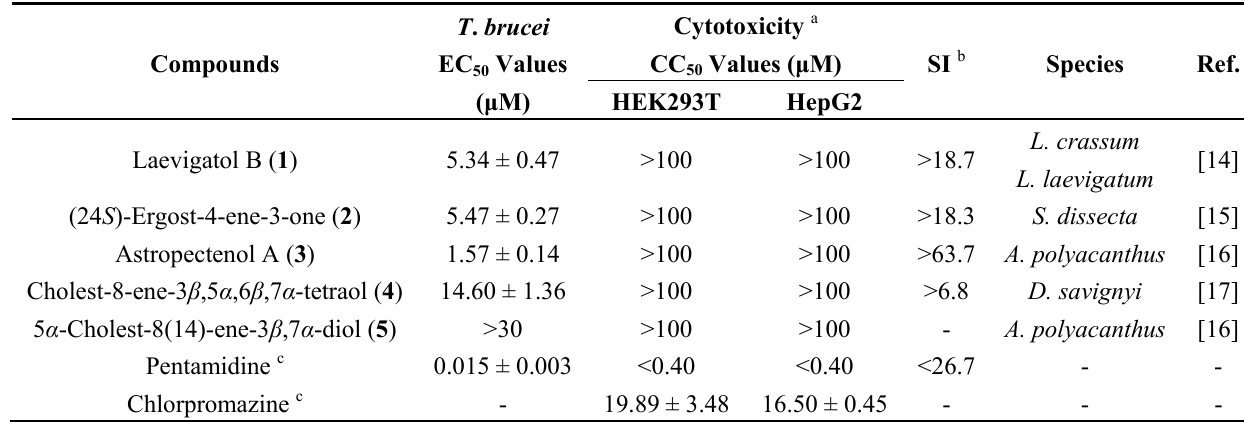
Table 1. In vitro antiparasitic and cytotoxic activities of marine metabolites.